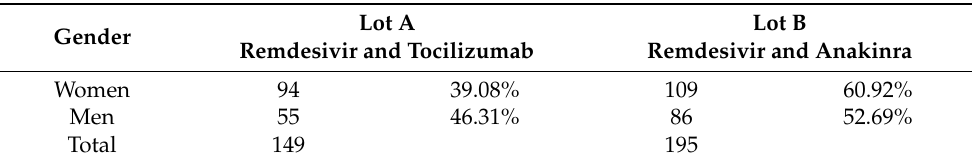
Table 3. Distribution of cases by